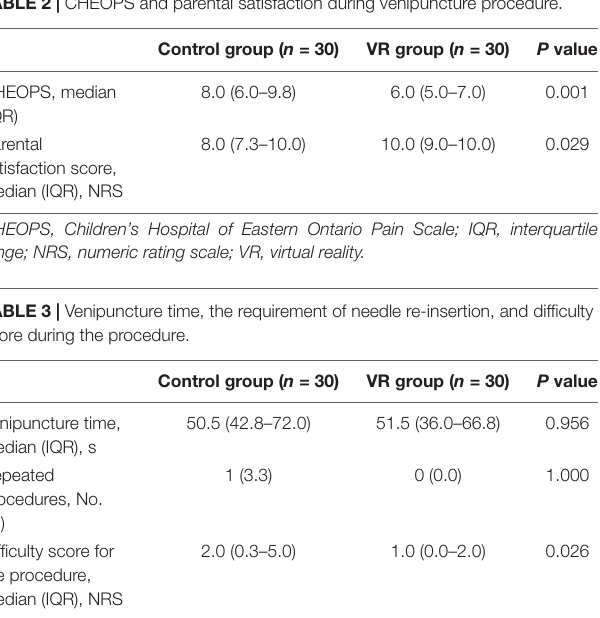
TABLE 1 | Patients’ characteristics. TABLE 2 | CHEOPS and parental satisfaction during venipuncture procedure.